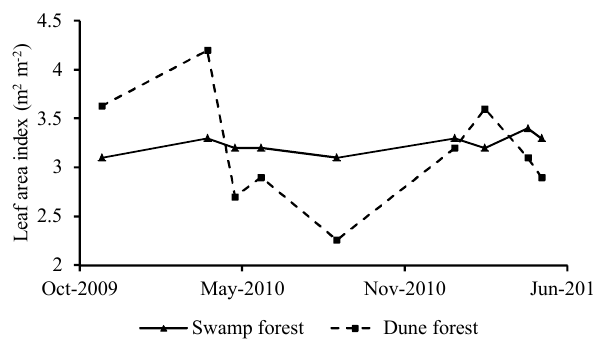
Fig. 2. Leaf area index measured at the swamp forest (above the ferns) and dune forest